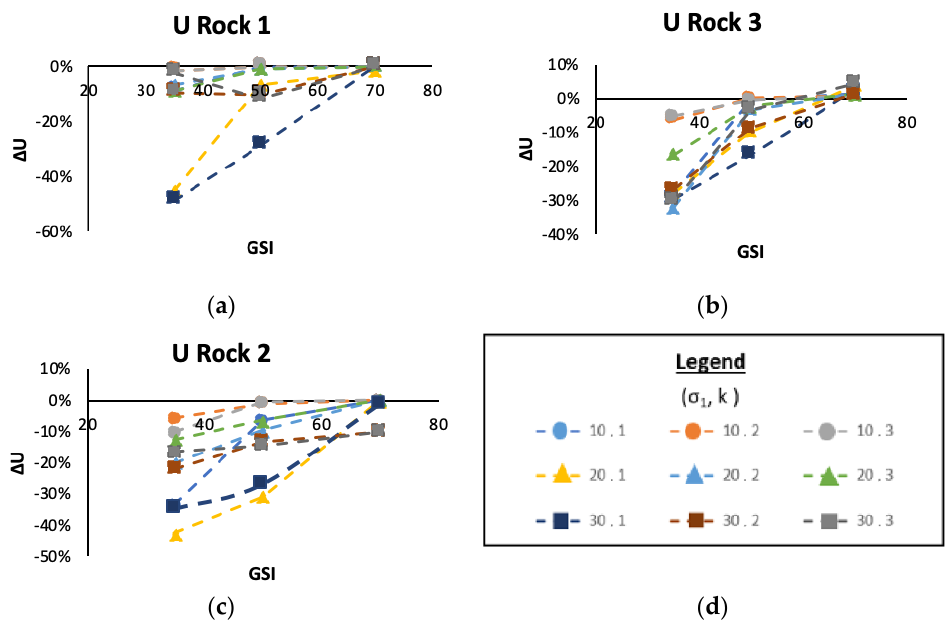
Figure 7. Variation of the relative deviation of wall displacement for GSI values of 35, 50, and 70 (∆U is the relative deviation), ( a ) Rock 1, ( b ) Rock 2, ( c ) Rock 3, ( d ) legend. Second, when rock type and GSI are held constant, increased in situ stress causes an increase in the relative deviation (Figure 8). The number of cases in a ±5% variation is greatest when the major principal stress is 10 MPa. The highest relative deviation obtained for a major principal stress of 10 MPa is 34% compared to 49% for a major principal stress of 30 MPa. The relative deviation decreases as the deviatoric constant k increases. Indeed, the largest relative deviation is obtained for k = 1, although the effect of GSI should be considered.